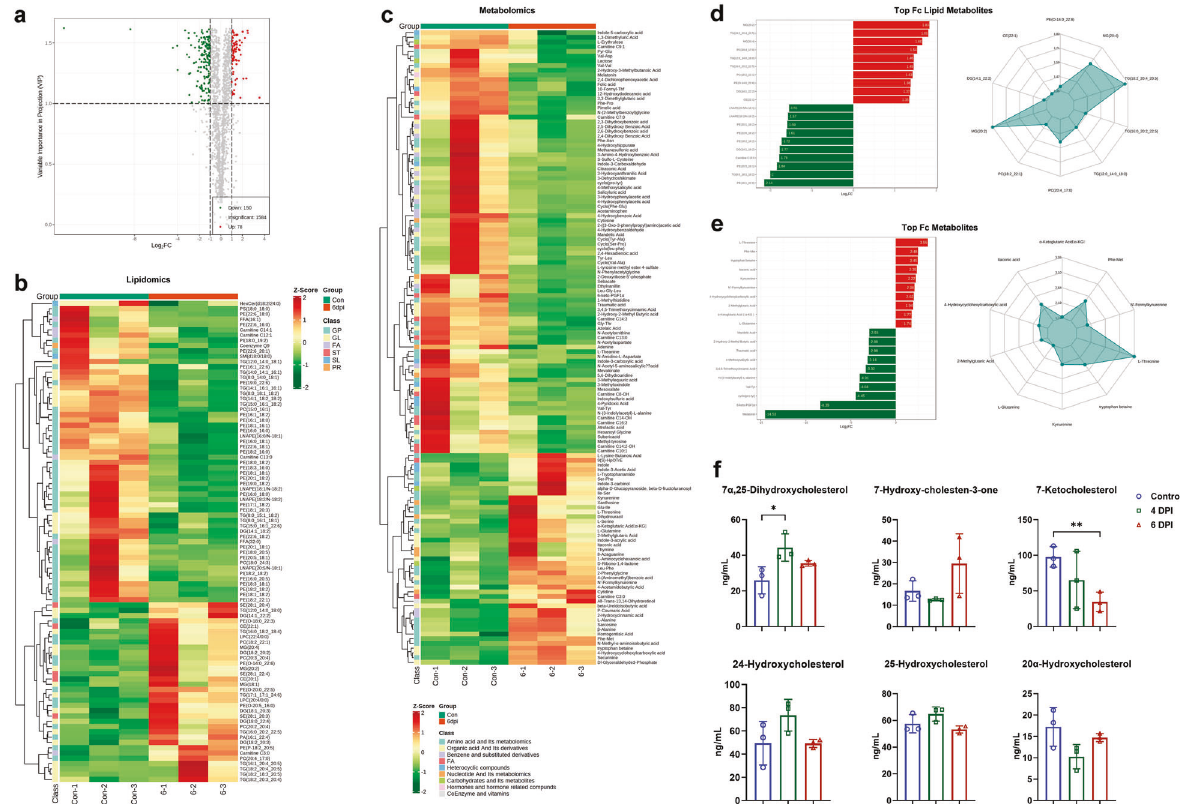
Fig. 5 Lipidomic and metabolomic pro fi ling of sera from infected minks at 6 dpi compared with that of control at 0 dpi. a Volcano plot showing the relative content differences of metabolites between minks at 0 and 6 dpi and the signi fi cance of statistical differences. Each dot in the volcano plot represents a metabolite, with green dots representing downregulated differential metabolites, red dots representing upregulated differential metabolites, and gray dots representing metabolites detected but not signi fi cantly different. b Cluster heatmap of differential lipidome. CE cholesterol ester, DG diacylglycerides, TG triglycerides, FA fatty acid, FFA free fatty acids, PC phosphatidylcholine, LPC lysophosphatidylcholine, PE phosphatidylethanolamine, LPE lysophosphatidyl ethanolamine, LPG lysophosphatidylglycerol, PI phosphatidy- linositol, PS phosphatidylserine, LPO lipid peroxide. c Cluster heatmap of the differential metabolome. d Bar chart and radar map of differential lipidome. e Bar chart and radar map of differential metabolites. f Serum concentrations of six steroids. * P < 0.05, ** P < 0.01. Data are presented as mean ± standard deviation with individual data points